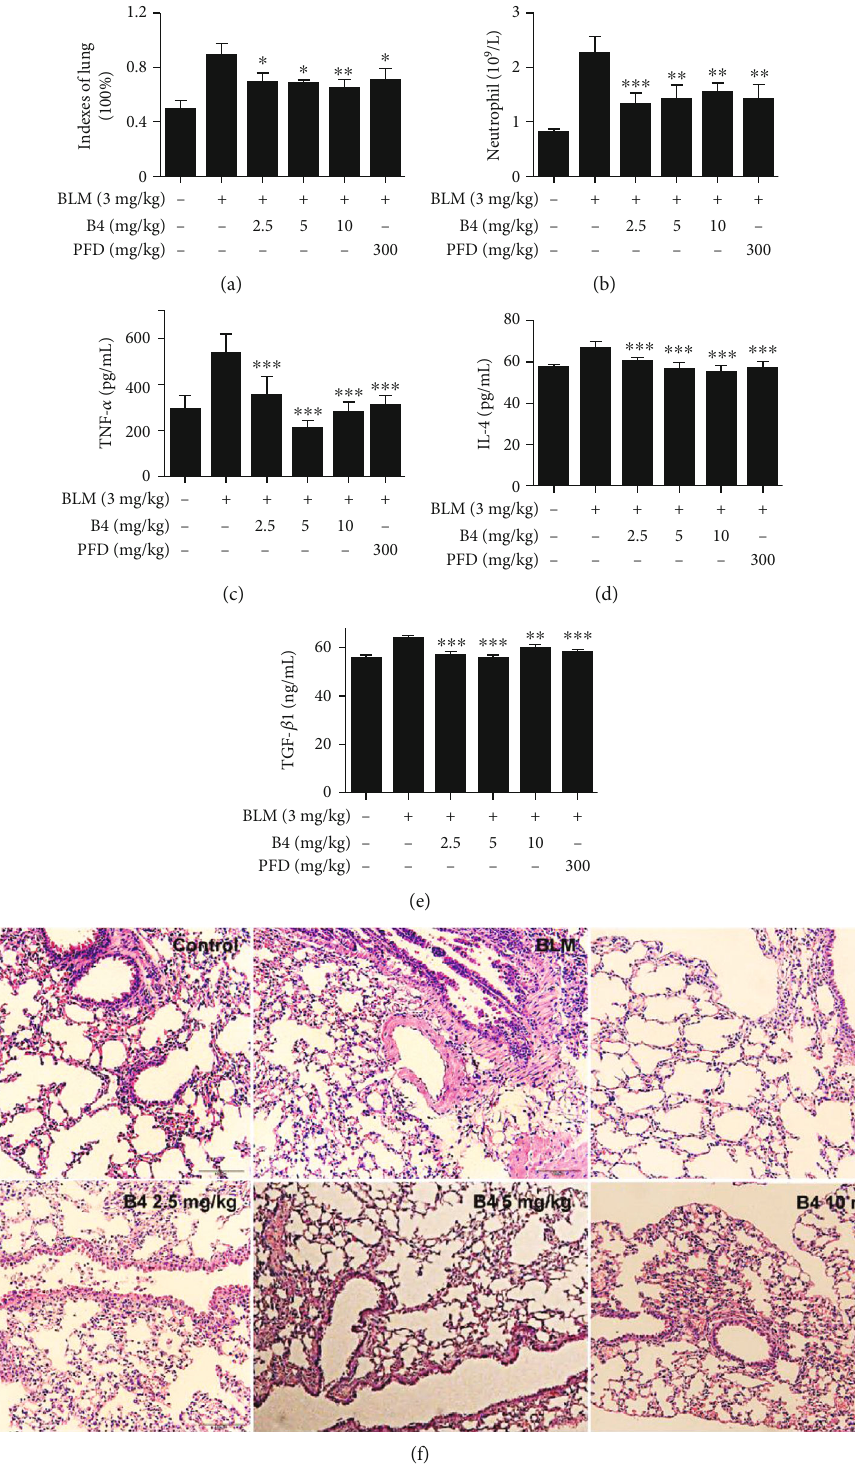
Figure 6: B4 rescued BLM-stimulated ALI in mice. (a) Mice were treated with BLM (3 mg/kg, i.t.). After BLM injection, mice were injected with B4 at 0, 3, 24, and 48h. PFD group mice were administrated with PFD (300mg/kg, i.g.) at 0, 3, 24, and 48 h after BLM treatment. Lung tissues were weighed, and lung index was calculated ( n = 20 ). (b) Blood samples were collected. Blood neutrophils were examined by the blood analyzer, ( n = 20 ). (c – e) The serum in fl ammatory cytokines TNF- α , IL-4, and TGF- β 1 were detected by ELISA ( n = 10 ). (f) H&E staining of the lung tissue (H&E, original magni fi cation, 200x). PFD (300mg/kg, i.p.) was the positive control ( n = 10 ). ∗ P < 0 : 05 , ∗∗ P < 0 : 01 , and ∗∗∗ P < 0 : 001 , compared to the BLM-alone